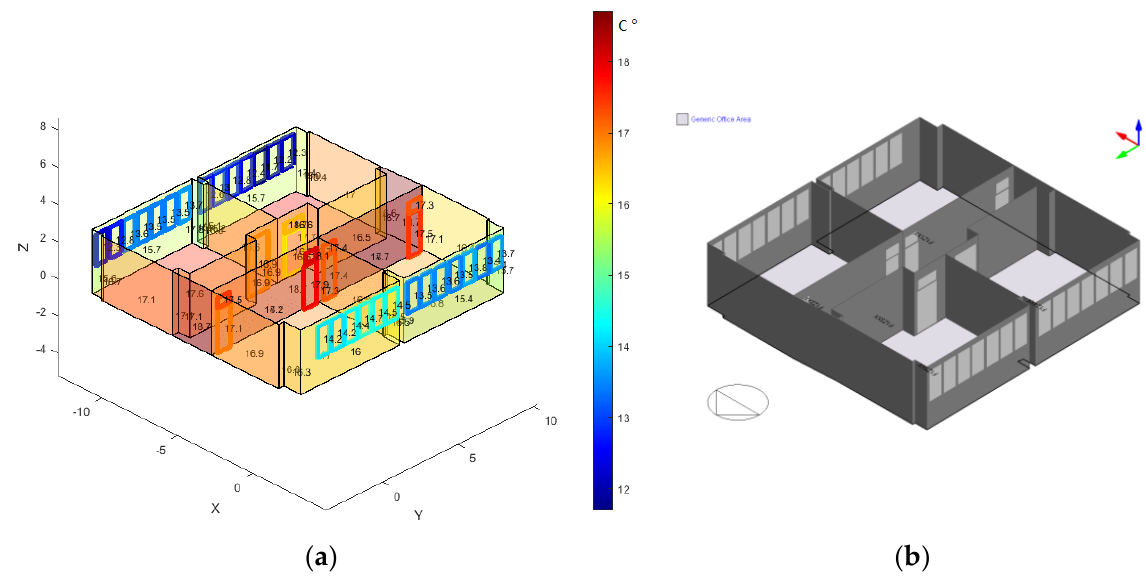
Figure 4. ( a ) T-BIM model, with surface temperatures in its viewer. ( b ) GBXML model of adiabatic adjacencies and envelope transmittance calculated with the DesignBuilder viewer.